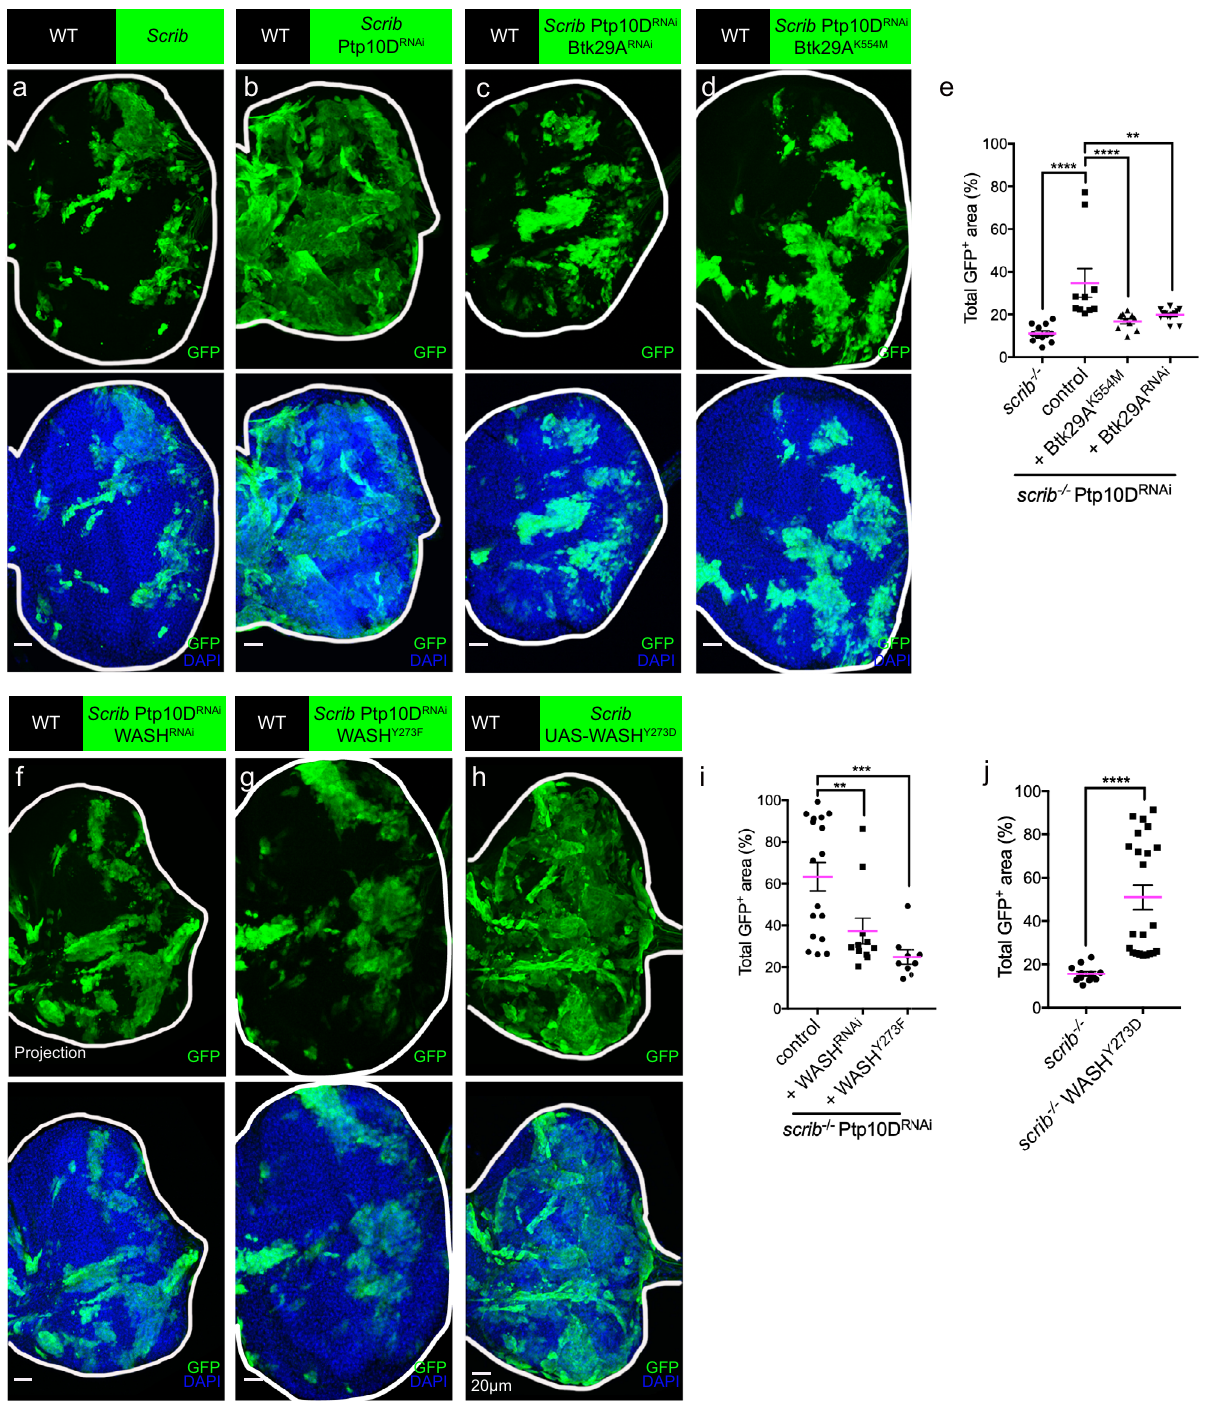
Fig.1|Ptp10D/Btk29A/WASHcircuitactsin scrib − / − -inducedtumor-suppressive cell competition model. a – d Eye-discs bearing MARCM-induced mosaics of